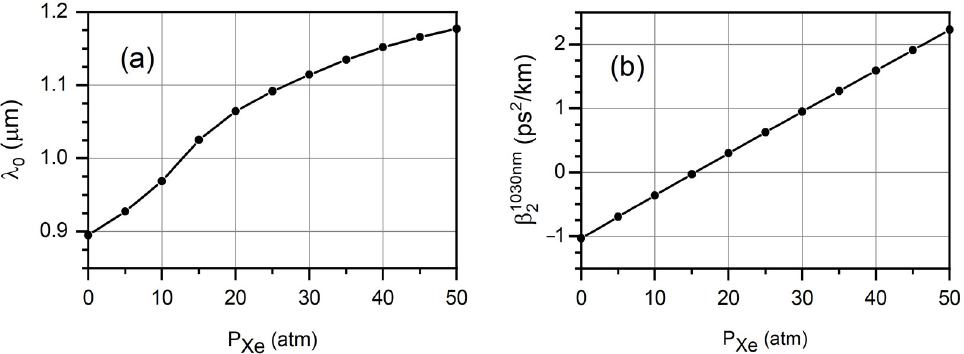
Figure 3. ( a ) Zero dispersion wavelength λ 0 as a function of xenon pressure for the fundamental mode of the fiber. ( b ) Group velocity dispersion β 2 for the fundamental mode at a pump wavelength of 1.03 μm as a function of the xenon pressure.